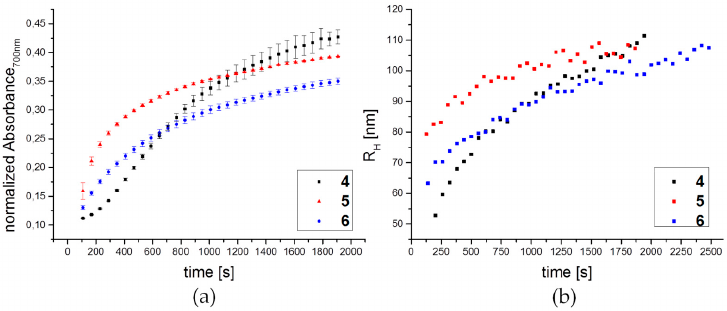
Figure 4. Kinetic analysis of glyco-AuNP interaction with ConA by ( a ) UV-Vis absorbance at 700 nm and ( b ) Representative evolutions of the hydrodynamic radii obtained from time-dependent DLS measurements at K D,app concentrations of Con A.